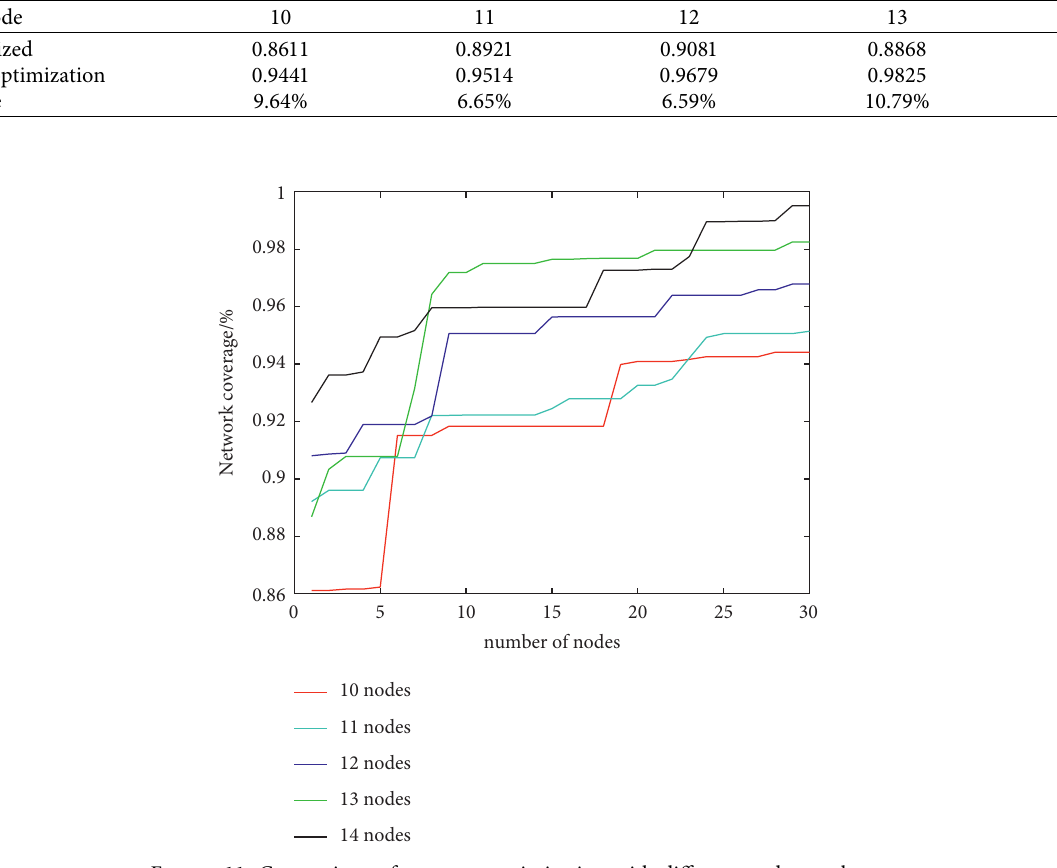
Figure 11: Comparison of coverage optimization with different node numbers.